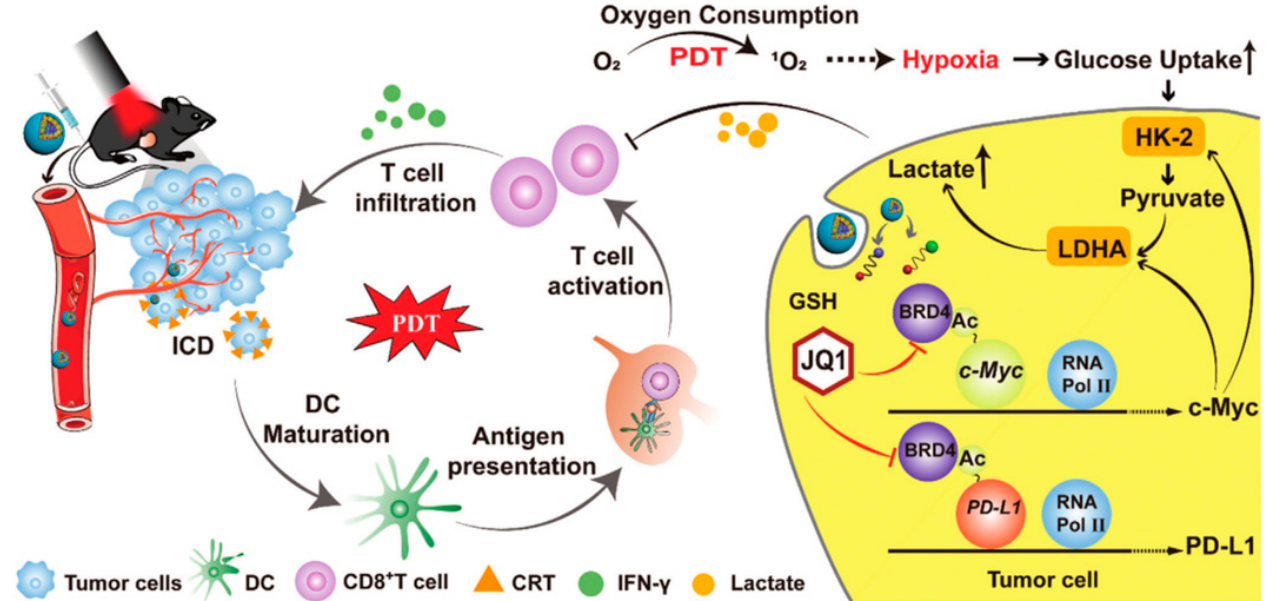
Figure 4. Mechanism of HCJSP-based combination immunotherapy for pancreatic tumors: PDT mediated by HCJSP-induced ICD in tumor cells, enhanced DC maturation, stimulated CTL activation, and resulted in tumor regression. Meanwhile, BRD4i JQ1 reduces the immunosuppressive tumor microenvironment and glycolysis stimulated by PDT by blocking the transcription of the c-Myc pathway downstream genes HK-2 and LDHA. Meanwhile, JQ1 specifically expressed down-regulated IFN- γ -induced PD-L1 surface tumor cell expression against PDT-inducible adaptive immune evasion. Reproduced with permission from Ref. [72], Copyright (2021) Sun Fang et